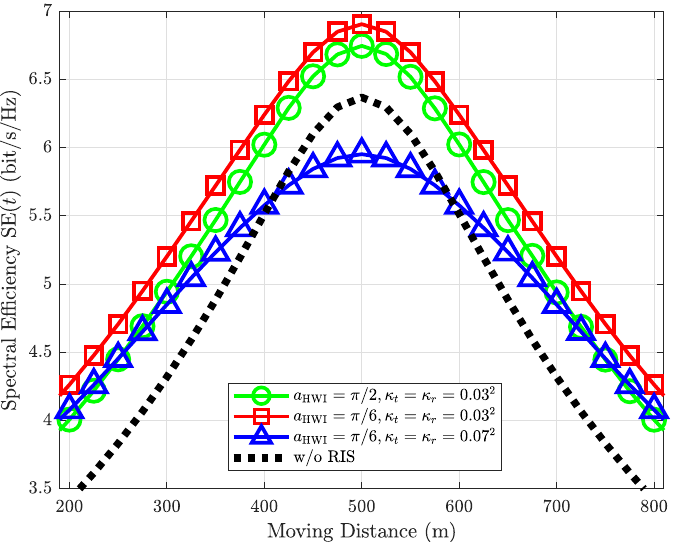
Figure 8. Spectral efficiency of the multi-RIS system with different HWI for one vehicle pass. K = 8.